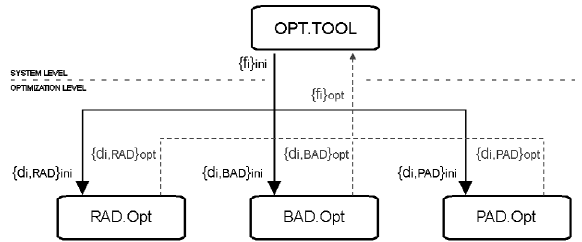
Fig. 2. The OPT.TOOL collaborative architecture. it reads the local design varables { f } ini and takes out the optimal values { f } opt .